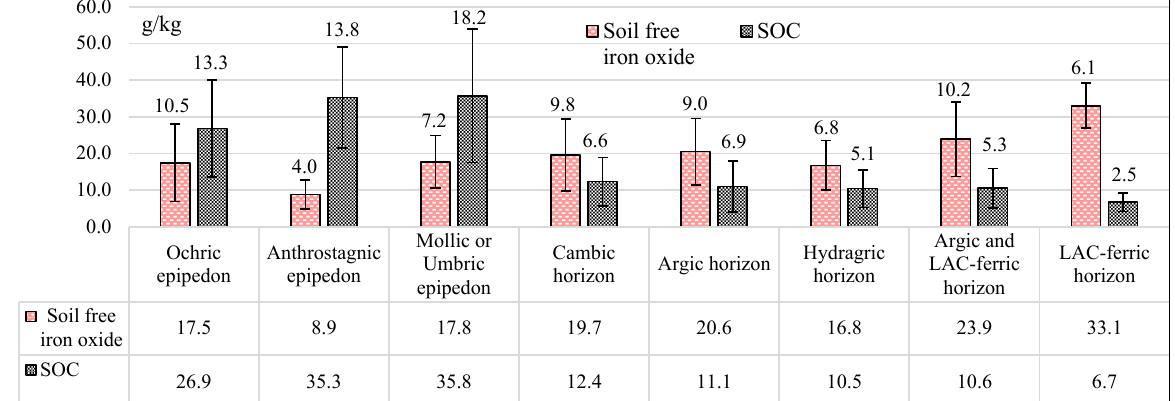
Figure 4. Mean value and standard deviation of soil free iron oxide and SOC content of diagnostic horizons.